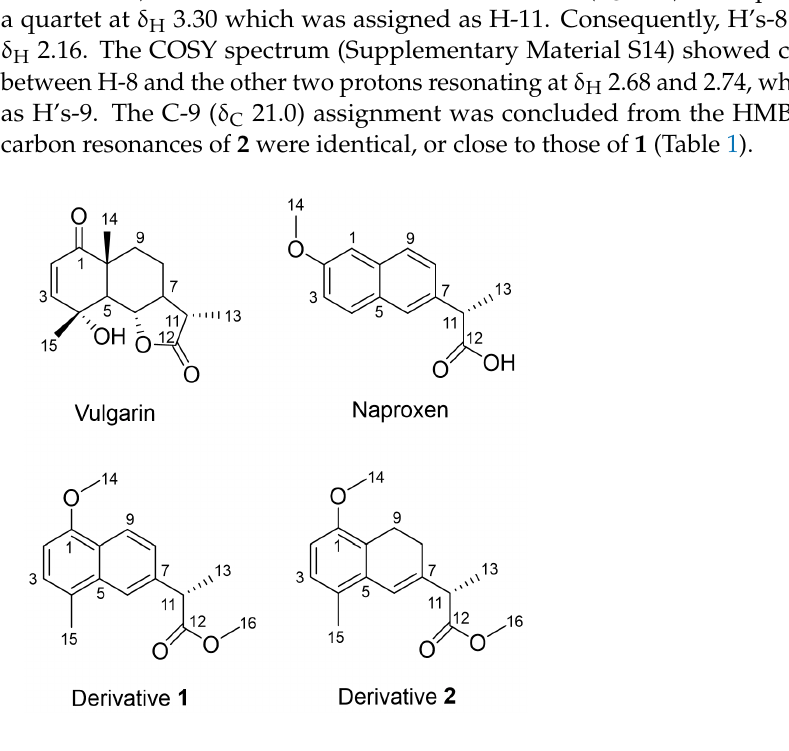
Table 1. NMR spectroscopic data (600 MHz, CDCl 3 ) of vulgarin and derivatives 1 and 2 . Vulgarin